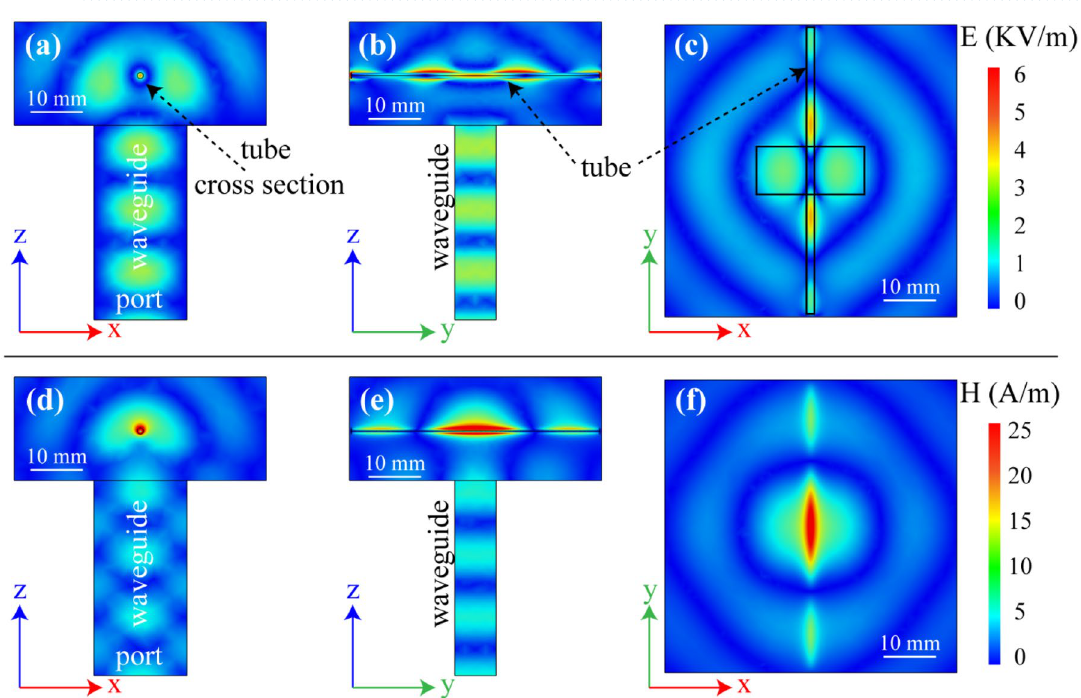
Figure 5. Simulation results for ( a – c ) electric and ( d – f ) magnetic field distribution with three different projections at 12